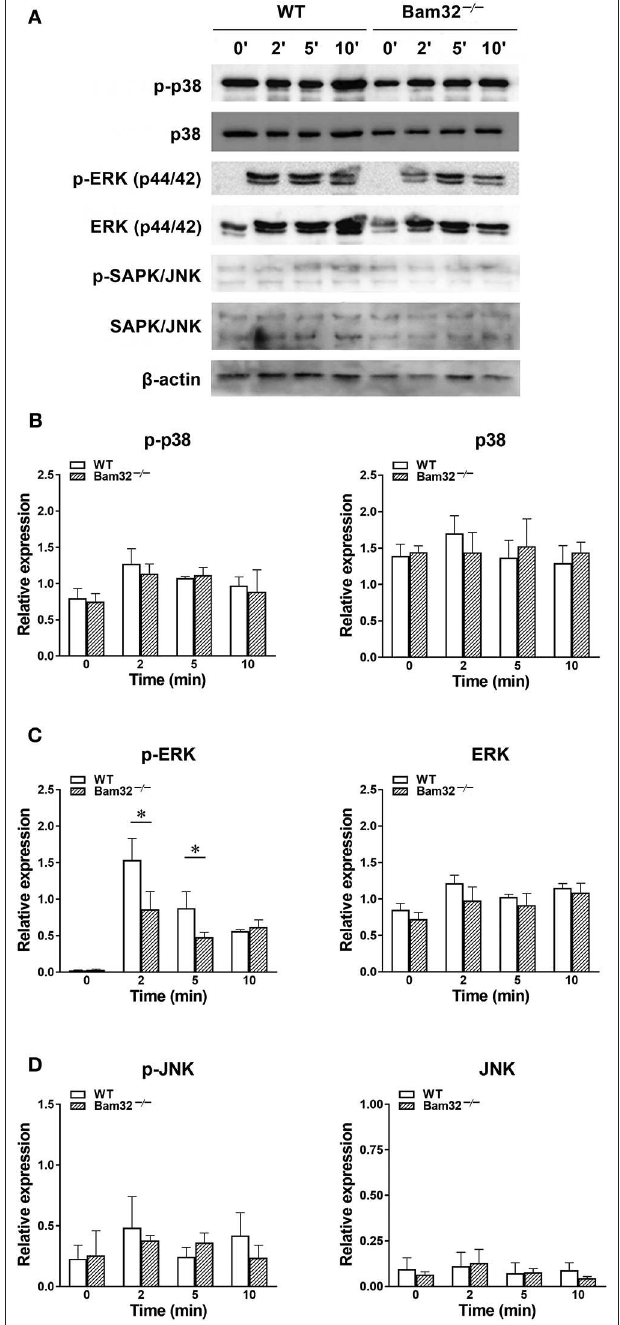
FIGURE 5 | WKYMVm-induced phosphorylation of p38, ERK1/2 and JNK MAPK in isolated WT and Bam32 − / − neutrophils. (A) Representative original Western blots of phosphorylated and total p38, ERK1/2, and JNK MAPK determined in bone marrow-derived neutrophils from WT and Bam32 − / − mice before (0min) and 2–10min after treatment with WKYMVm (0.1 µ M). Levels of phosphorylated (p) and total p38 (B) , ERK1/2 (C) , and JNK (D) determined in bone marrow-derived neutrophils from WT and Bam32 − / − mice before (0min) and 2–10min after treatment with WKYMVm (0.1 µ M). Mean ± SEM, n = 3. *Significant differences between WT and Bam32 − / −